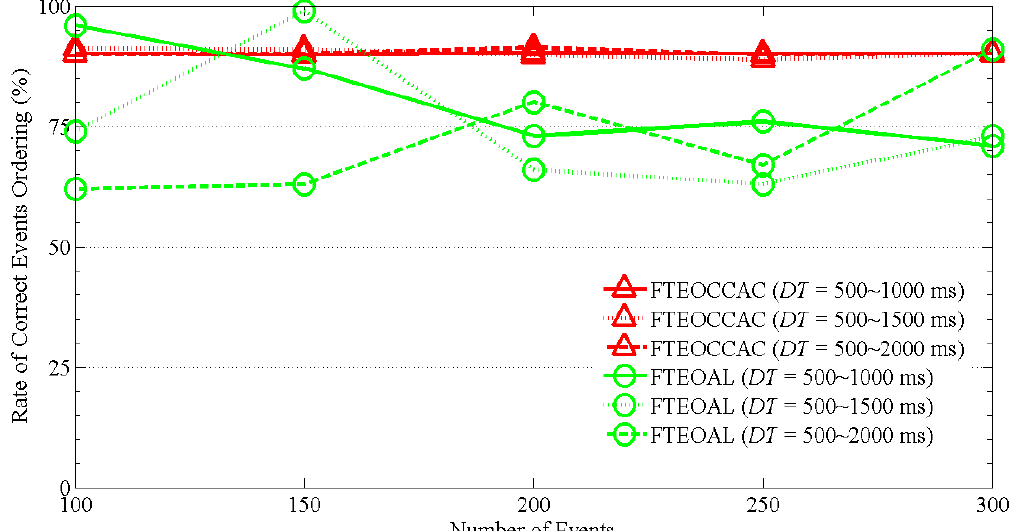
Figure 7. RC in FTEOCCAC and FTEOAL for different DT ( P l = 0-30%, DTG = 100 ms, P l =